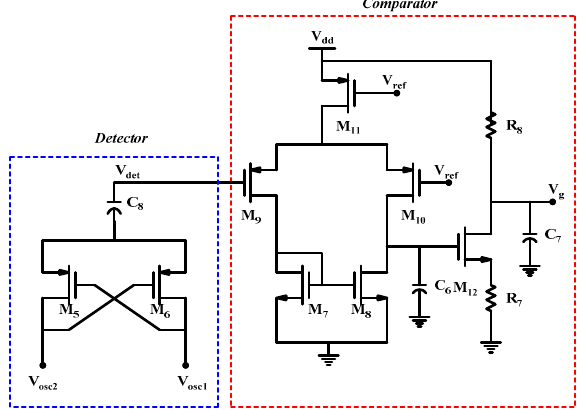
Figure 6. Circuit of the detector and comparator in the voltage controlled oscillator.